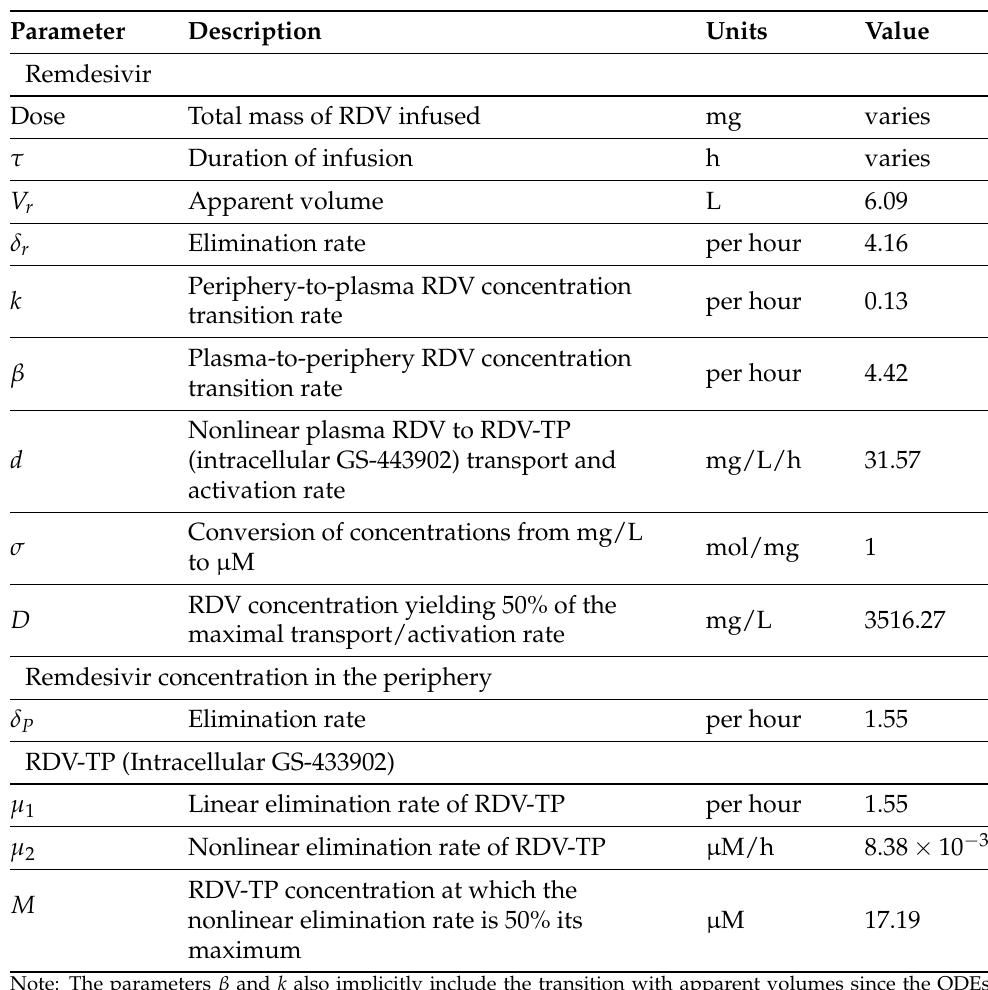
Figure 1. Median RDV plasma concentration from single-dose experiments [15], with different RDV dose sizes and infusion durations, compared to our pharmacokinetic model prediction (Equation (1)) simulated in R [31] given ( A ) 2-h infusions of 3 mg, 10 mg, 30 mg, 75 mg, 150 mg, 225 mg and ( B ) 1-h infusion of 150 mg. ( C ) Linear regression comparing the model predictions with the data to demonstrate how well the model explains the data. Data from 75 mg dosing excluded in the fitting, see Supplementary Materials Text S1 for details and Figure S1 for comparison. For cases where Humeniuk et al. (2020) [15] give plasma concentrations following multi-dose administration, we use the first dose only. Table 1. Pharmacokinetic model parameter